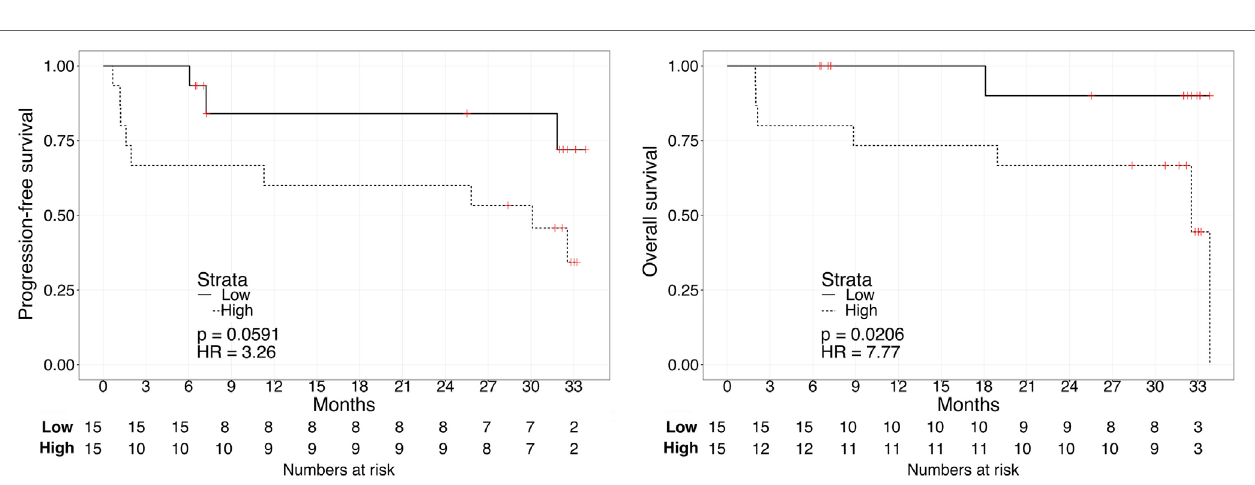
FigUre 1 | Kaplan–Meier curves for PFs (left) or Os (right) in ccrcc patients according to urine biomarker score level . The prospective cohort of patients ( N = 29) was classified as 14 “Low” (solid) vs. 15 “High” (dashed) biomarker score at the time of